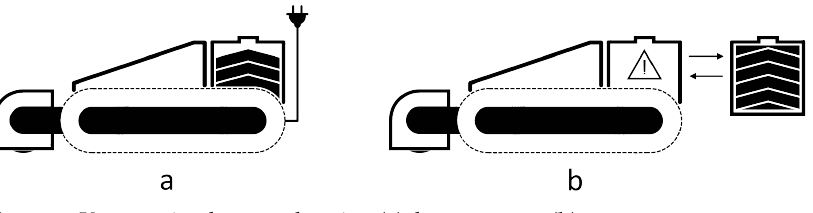
Figure 6. Key metrics: battery charging ( a ); battery swap ( b